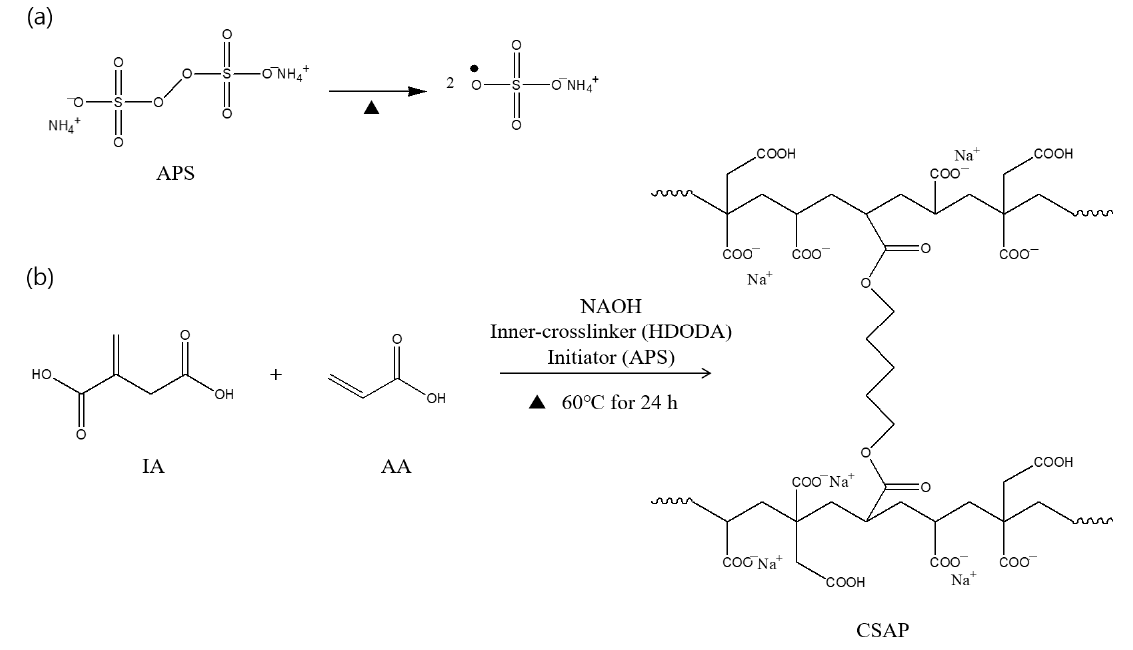
Figure 1. Synthetic procedures for CSAP: ( a ) thermal decomposition of ammonium persulfate, ( b ) chain propagation and crosslinking.